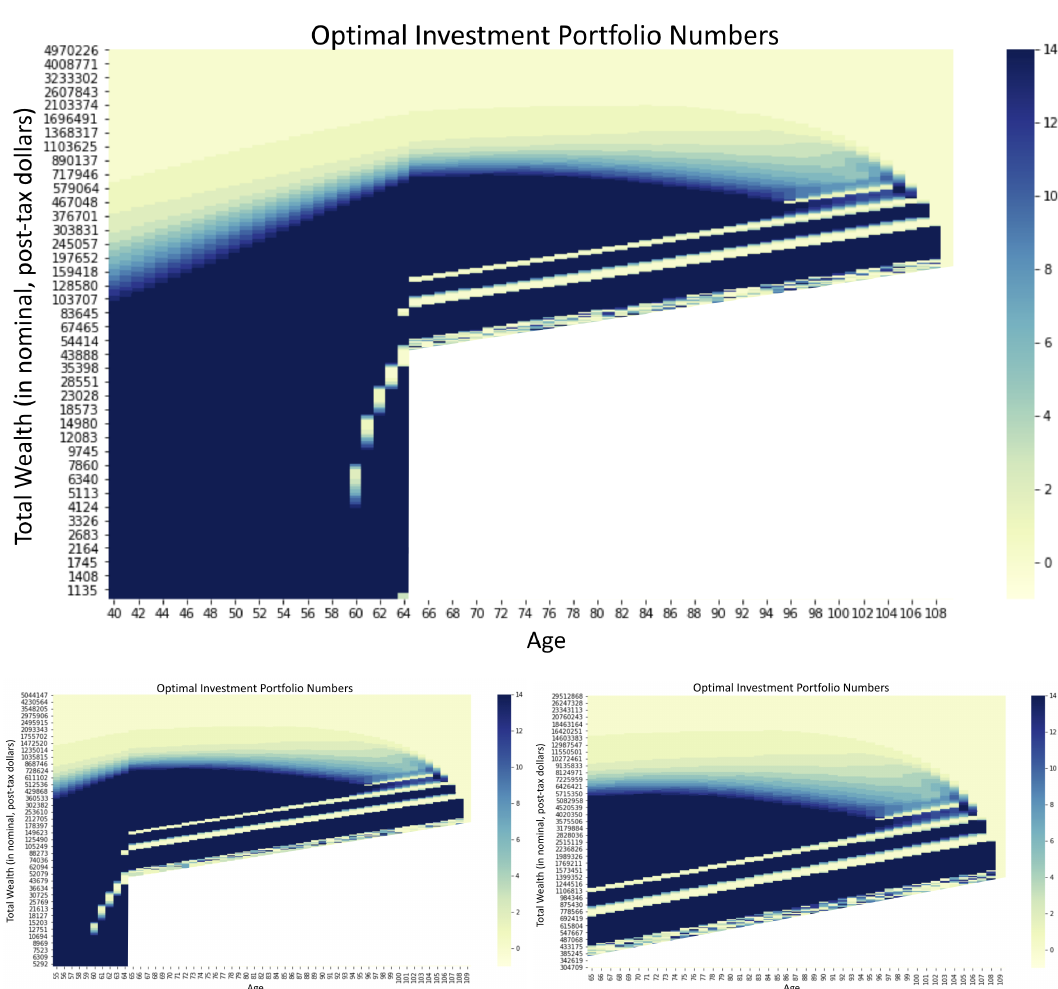
Figure 2. Optimal investment strategies. Top panel: The optimal investment strategy for Investor #1 as a function of the investor’s age on the horizontal axis and wealth, in nominal post-tax dollars, on the logarithmic scaled vertical axis. The potential investment portfolios on the efficient frontier are numbered 0 to 14, in order of increasing aggressiveness. The darker the color in the figure, the higher the number of the optimal portfolio investment. Note that a white region starting at age 65 has been inserted to cover low wealth values where bankruptcy is guaranteed at the beginning of the year, making the investment choice during the year irrelevant. Lower left panel: The optimal investment strategy for Investor #2. Lower right panel: The optimal investment strategy for Investor #3 with small wealth values that correspond to the white region removed. Note that all three panels show similar patterns of